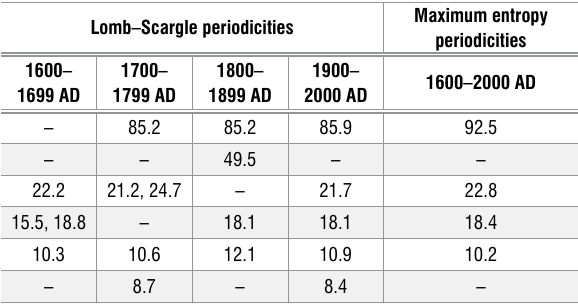
Figure 5: Maximum entropy spectral analysis of the Pafuri baobab data for the time period between 1600 and 2000. The blue curve is a spline fit of the identified